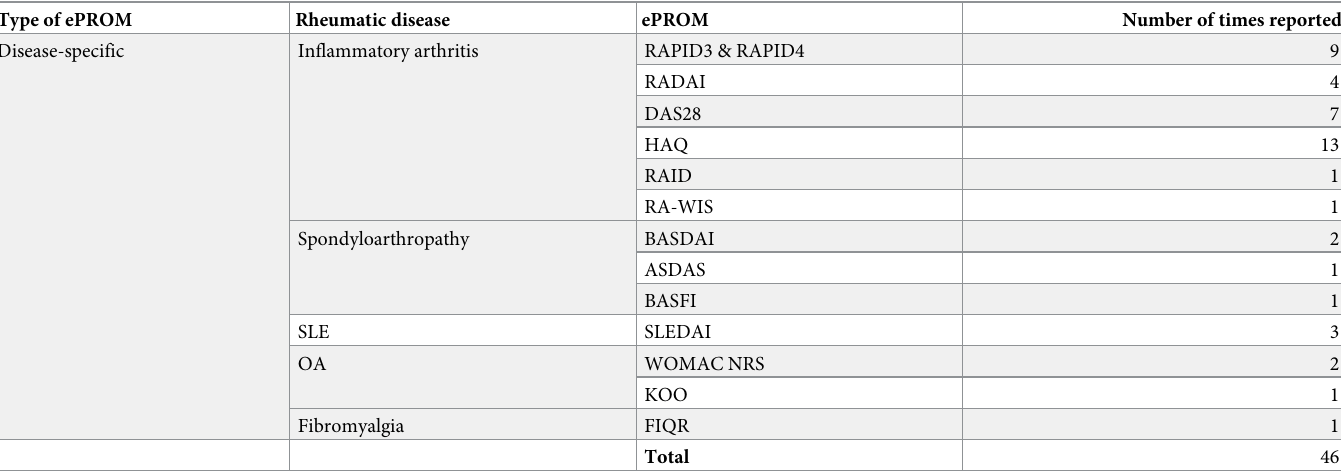
Table 2. Disease-specific